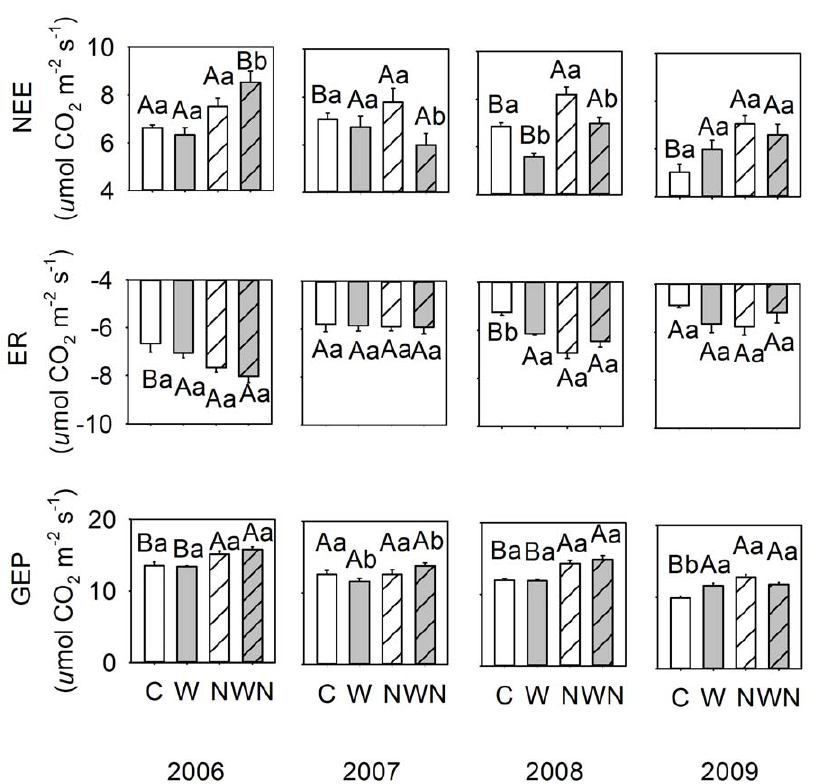
Figure 3. Growing season mean (n=6) net ecosystem CO 2 exchange (NEE), ecosystem respiration (ER), and gross ecosystem productivity (GEP). Data are presented as mean 6 SE. Different letters indicate significant differences ( P , 0.05) among treatments with capital and small letters indicating differences between N and warming treatments, respectively. C = control, W = warming, N = N addition, WN = combined warming and N addition. doi:10.1371/journal.pone.0045205.g003 used to adjust for multiple comparisons. Regression with correction for autocorrelation and stepwise multiple linear analyses were used to examine the relationships of ecosystem C fluxes with soil moisture, and leaf area index. All statistical analyses were conducted with SAS software (SAS Institute Inc., Cary, NC, USA).